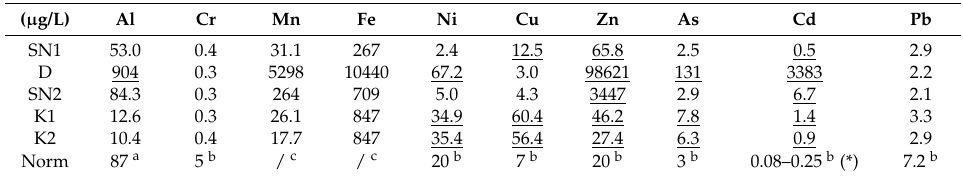
Figure 1. Schematic overview of the workflow of this study analogous to the concepts of a Toxicity Identification Evaluation (TIE). The numbered boxes represent the steps that were conducted in this study. Identification of predominant pollutant class(es) corresponds to phase 1 of a TIE and is necessary in cases where no background data are available (e.g., as illustrated by Burgess et al. [18]). The dashed arrow represents step 6 of the workflow, i.e., comparing the effects between field and reconstituted exposure scenarios. Table 1. Dissolved trace metal(loid) concentrations at the different sites. The underlined metal concentrations exceeded the surface water quality standards. Elements shaded in grey were used to reconstitute the metal mixtures. All values are in µg/L.